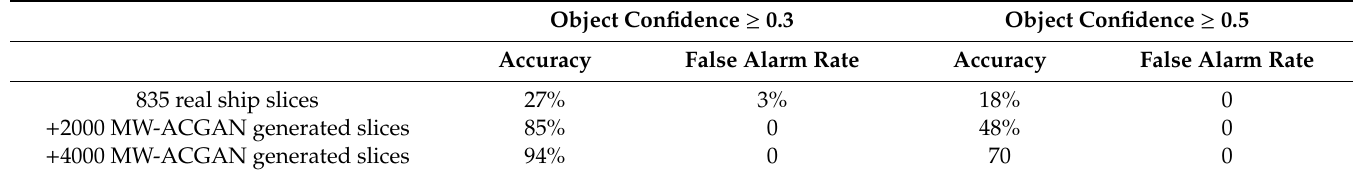
Table 5. Statistics of Yolo v3 detection